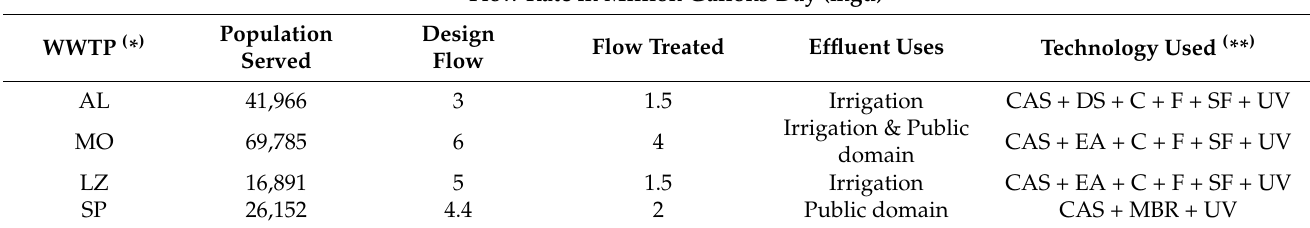
Table 1. Characteristics of